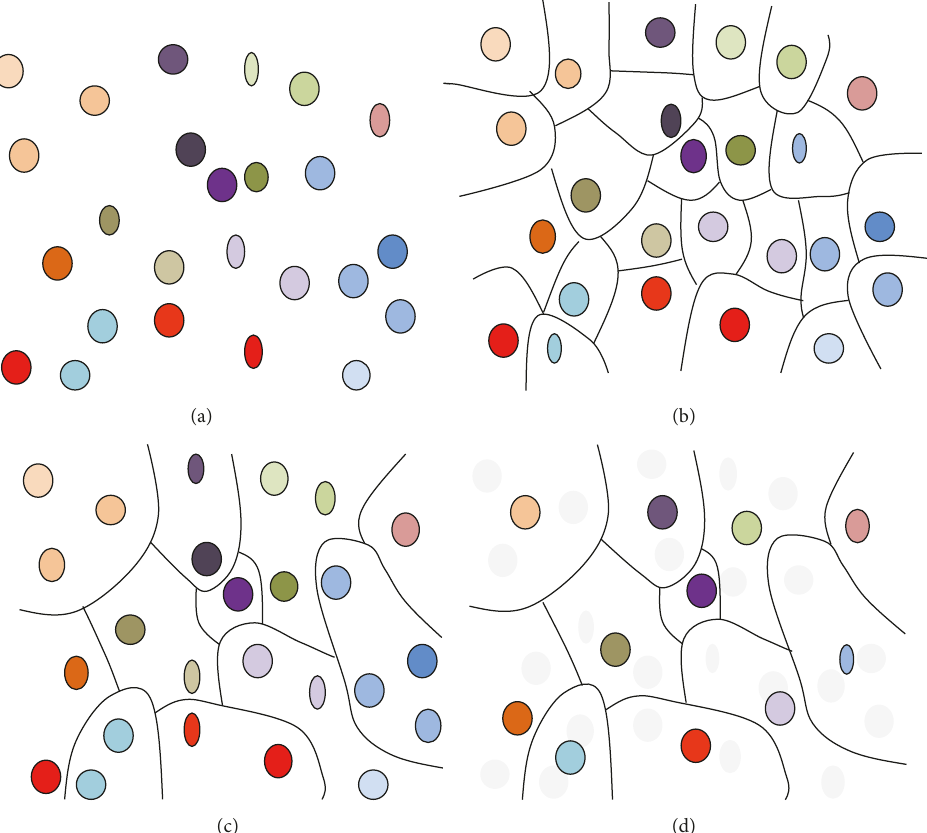
Figure 2: Concept of feature box. (a) Wind innovation vector field. (b) Cluster initialization. (c) Process of cluster scanning. (d) Superob within feature box.